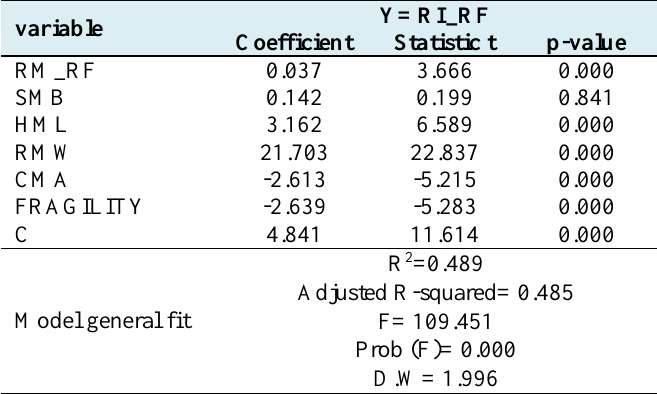
Table 9 . Estimation of the second research